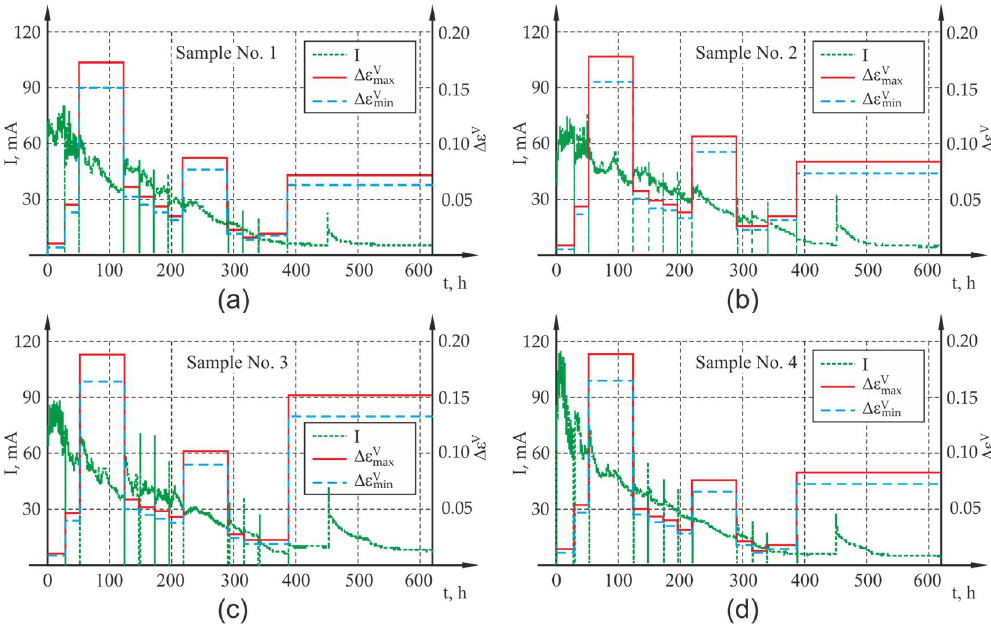
Figure 9. Coordinates of the tensors of e ff ective increments of volumetric strains produced by corrosion